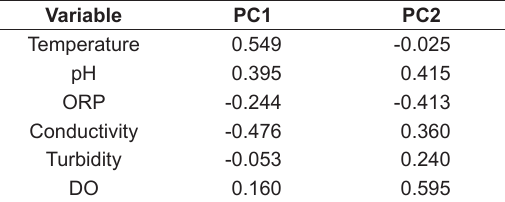
Table 3. Correlation values (scores) among limnological variables adjacent to macrophyte banks and components one and two of principal component analysis. Data from lotic, intermediate, and lentic compartments of Palmeiras and Retiro SHPs reservoirs, Sapucaí-Mirim River (SP, Brazil).